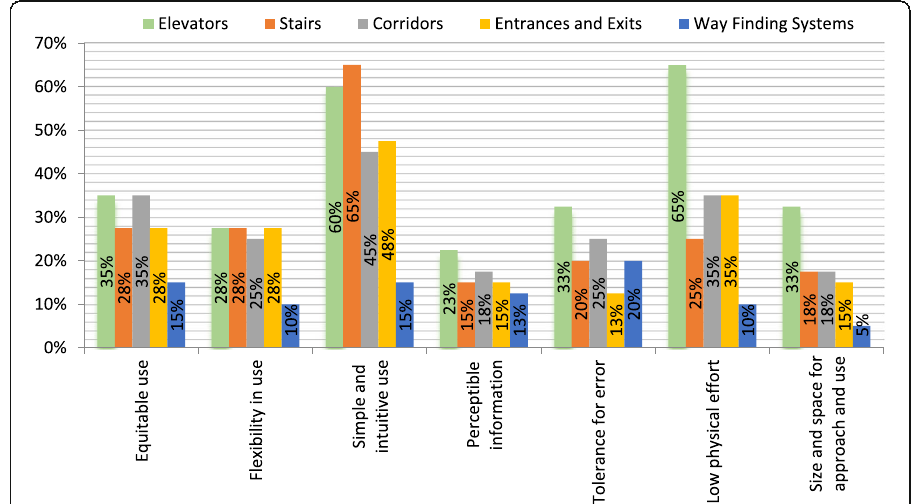
Fig. 30 Compliance of each element with each one of UD principles in building C “ The National Organization for Social Insurance — Government Sector